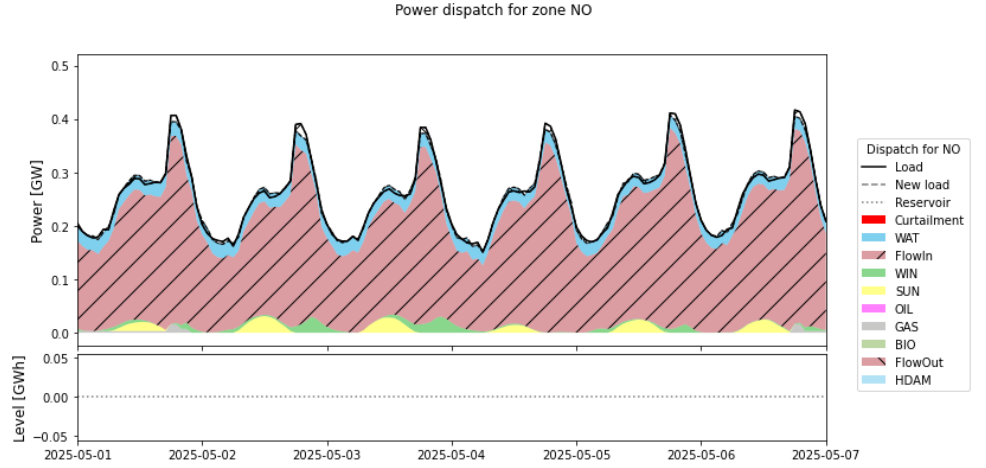
Figure 27. Moderate-Penetration Scenario 1(NH)—North zone (1–7 May 2025).